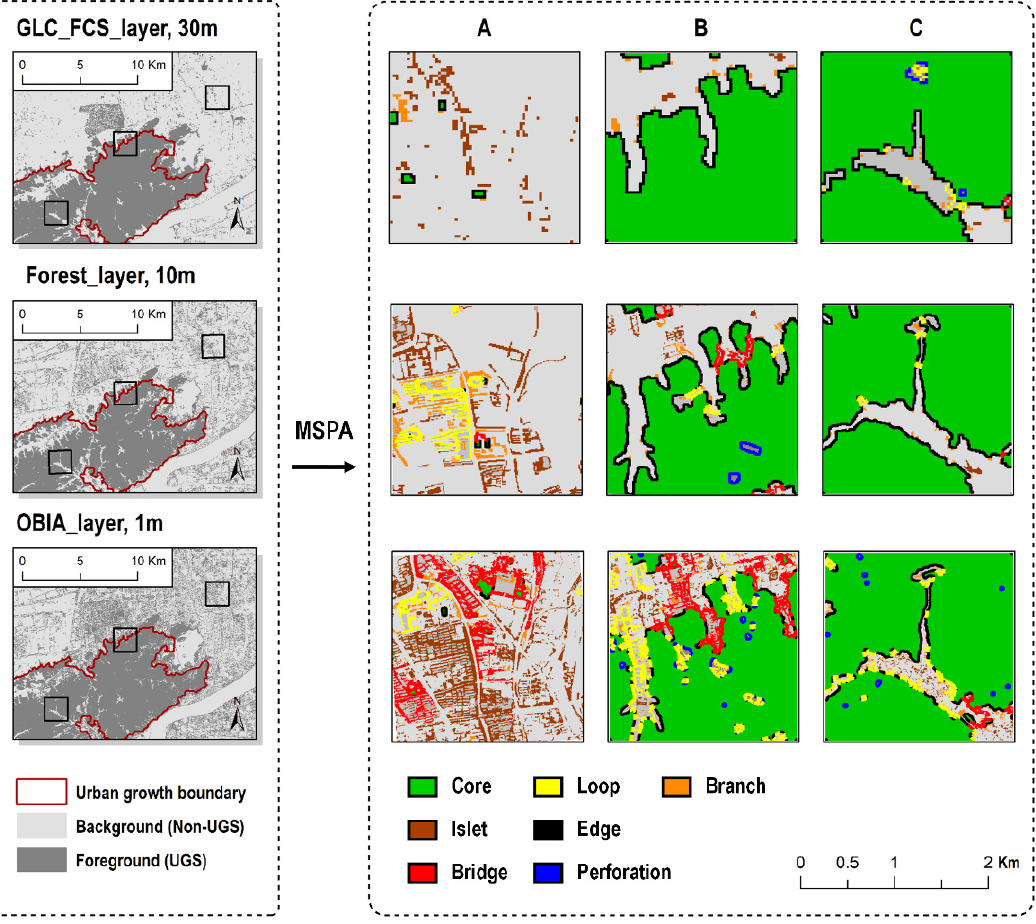
Figure 5. MSPA results of the three maps (GLC_GCS_layer, Forest_layer, and OBIA_layer) in the three scenarios (A, B, and C) with seven landscape elements. The distributions of A, B, and C are in Figure 1. Table 2. An inventory table of MSPA results for the three UGS cover maps. The proportion variation column displays the variation tendency of the proportion in total from low spatial resolution map to high-resolution map.